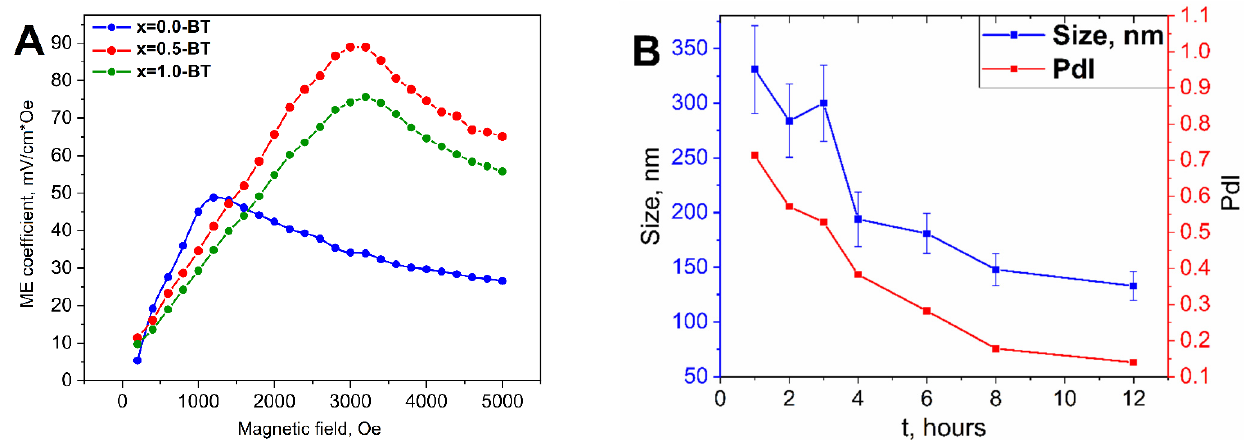
Figure 9. Magnetoelectric measurements ( A ) for the samples of x = 0.0-BT, x = 0.5-BT, and x = 1.0-BT and dynamics of average hydrodynamic size, and PdI change over ball milling time for the x = 0.0-BT by DLS ( B ).